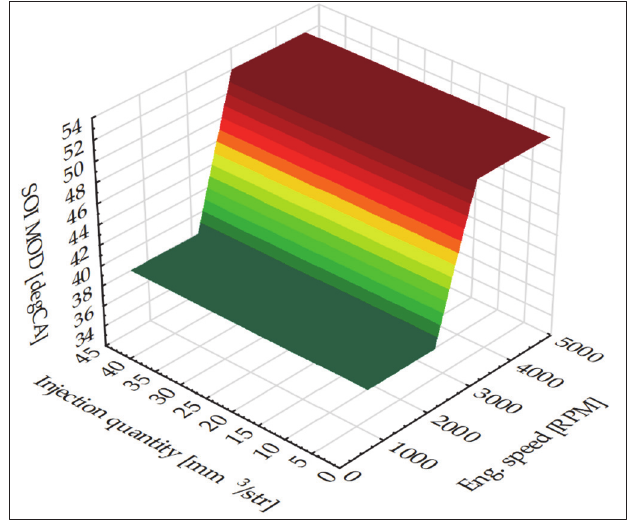
Figure 5. Modified map SOI.